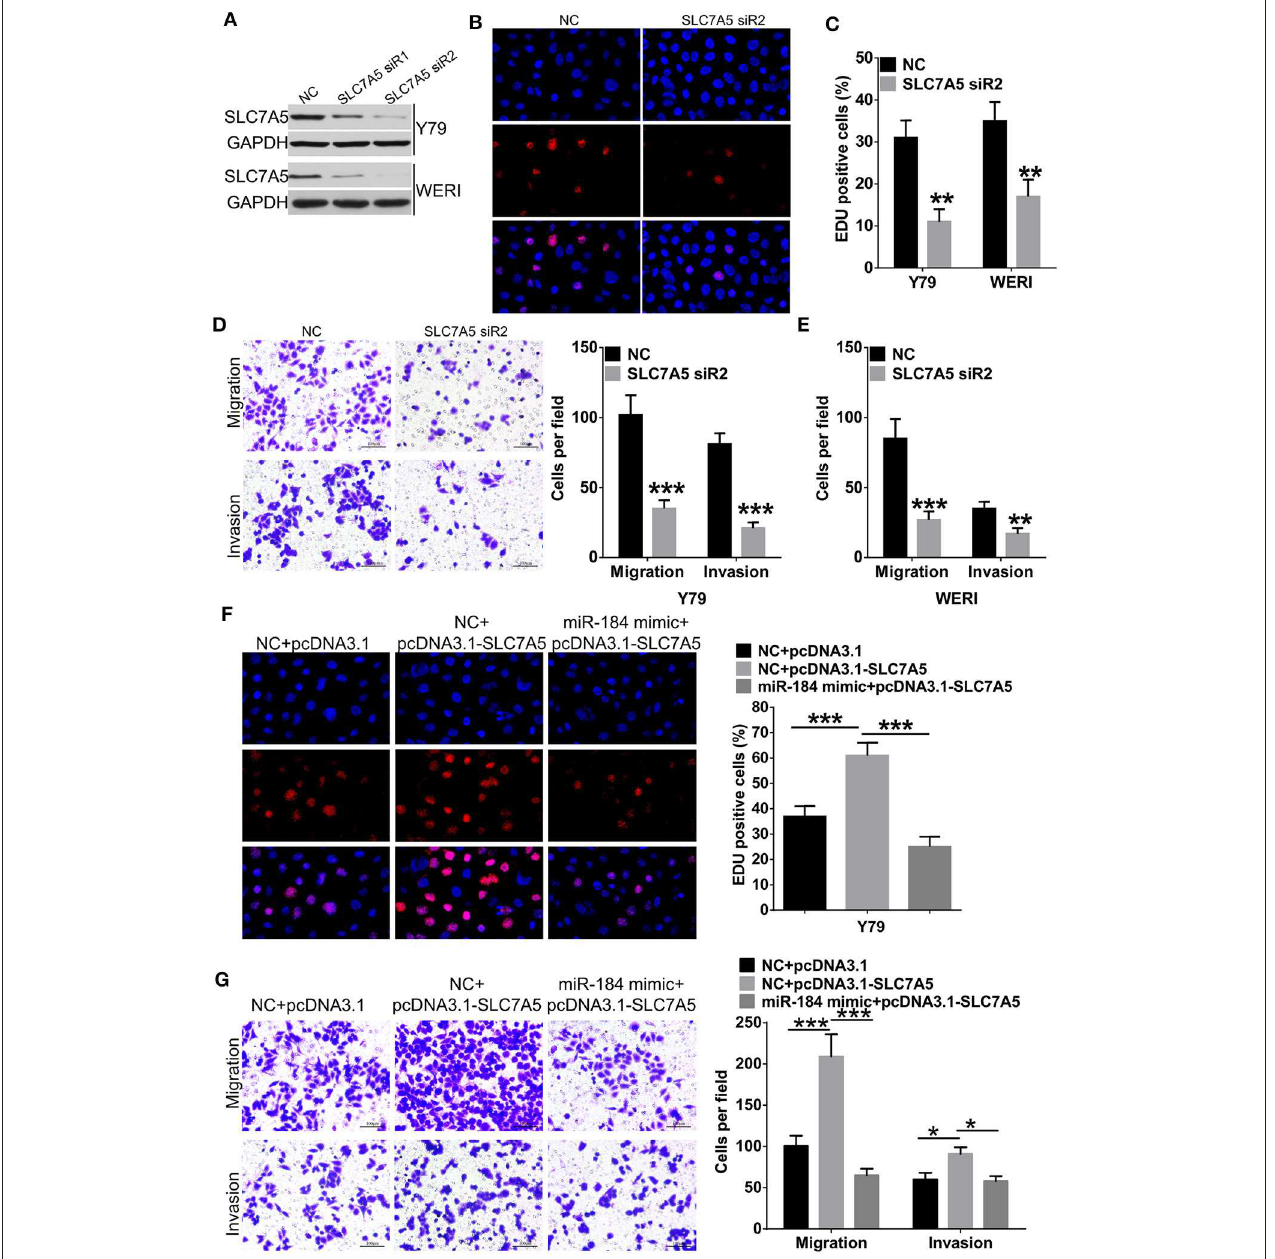
FIGURE 5 | miR-184 inhibits proliferation, migration, and invasion of retinoblastoma (RB) cells via targeting SLC7A5. (A) Western blot analysis of SLC7A5 expression in Y79 cells and WERI cells transfected with SLC7A5 siRNA. (B) EdU analysis of the cell proliferation ability in Y79 cells transfected with the SLC7A5 siRNA. (C) Statistical analysis of the EdU-positive cell ratio in Y79 cells and WERI cells transfected with the SLC7A5 siRNA. (D) Transwell assay of the migration and invasion ability inY79 cells transfected with the SLC7A5 siRNA. Scale bar: 100 µ m. (E) Statistical analysis of the cell numbers through the chamber in WERI cells transfected with the SLC7A5 siRNA. (F) EdU analysis of the cell proliferation ability in Y79 cells transfected with miR-184 mimic alone or together with SLC7A5 expression vector (pcDNA3.1-SLC7A5). (G) Transwell assay of the migration and invasion ability in Y79 cells transfected with miR-184 mimic alone or together with SLC7A5 expression vector (pcDNA3.1-SLC7A5). Data were presented as mean ± SD of three independent experiments. * P < 0.05, ** P < 0.01, *** P < 0.0001 vs. negative control group.